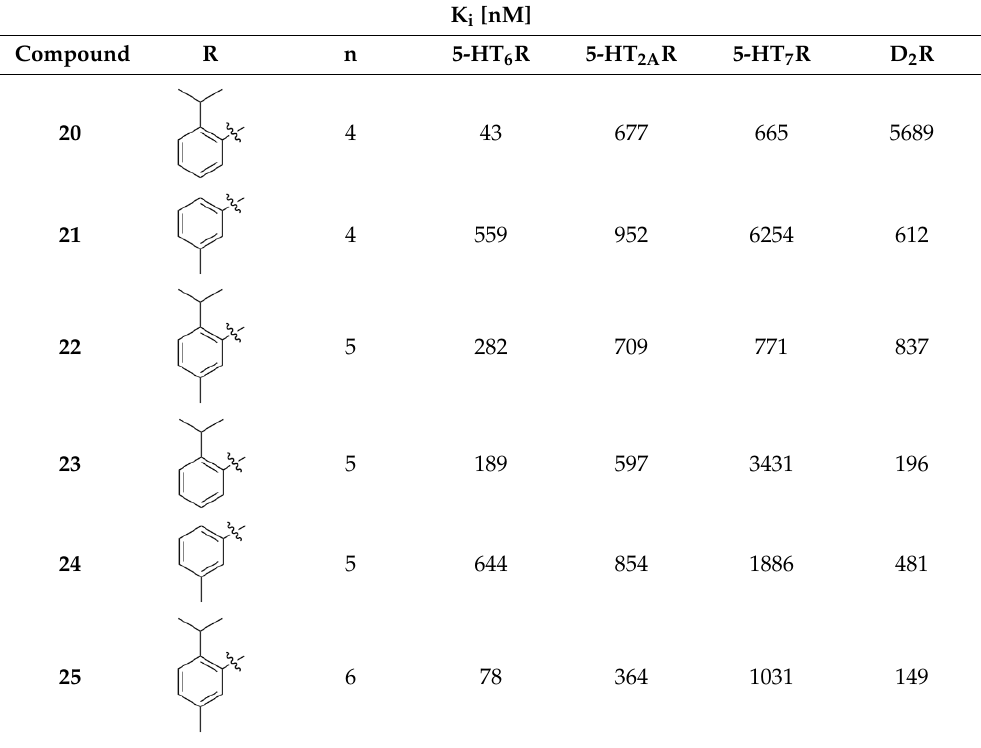
1 Tested experimentally in the radioligand binding assay in human cells stably transfected with a proper receptor; binding affinity, K i , expressed as the average of at least two independent experi- ments. Used radioligands: [ 3 H]-LSD (5-HT 6 R), [ 3 H]-ketanserin (5-HT 2A R), [ 3 H]-5-CT (5-HT 7 R) and [ 3 H]-raclopride (D 2 R); a data from Ali et al. [15]. First (series 1), modifications were carried out in the MST4 molecule involving the removal of an isopropyl group from position-2 (compound 1 ) and, conversely, the re- moval of the methyl group from position-5 (compound 2 ). These modifications showed that the substituent at position-2 was important, as removal of a 2-isopropyl substituent resulted in a 19-fold decrease in affinity for 5-HT 6 R compared to MST4 (K i = 207 nM for 1 vs. K i = 11 nM for MST4 ). In contrast, removal of the methyl group from position-5 (com- pound 2 ) resulted in only a 2-fold decrease in activity (K i = 21 nM). On the other hand, replacing the 2-isopropyl substituent with the 2- tert -butyl substituent led to compound 3 , which had comparable activity to MST4 (K i = 13 nM for 3 vs. K i = 11 nM for MST4 ). Fur- thermore, changing the position in the phenyl ring of both the isopropyl and the tert -butyl substituents from position-2 to positions-3 or -4 generally resulted in a decrease in activity (compare 2 vs. 4 vs. 6 and 3 vs. 5 vs. 7 ). Compounds 6 and 7 with substituents in position- 4 had the lowest affinity (K i = 416 nM and K i =150 nM, respectively) in this series.